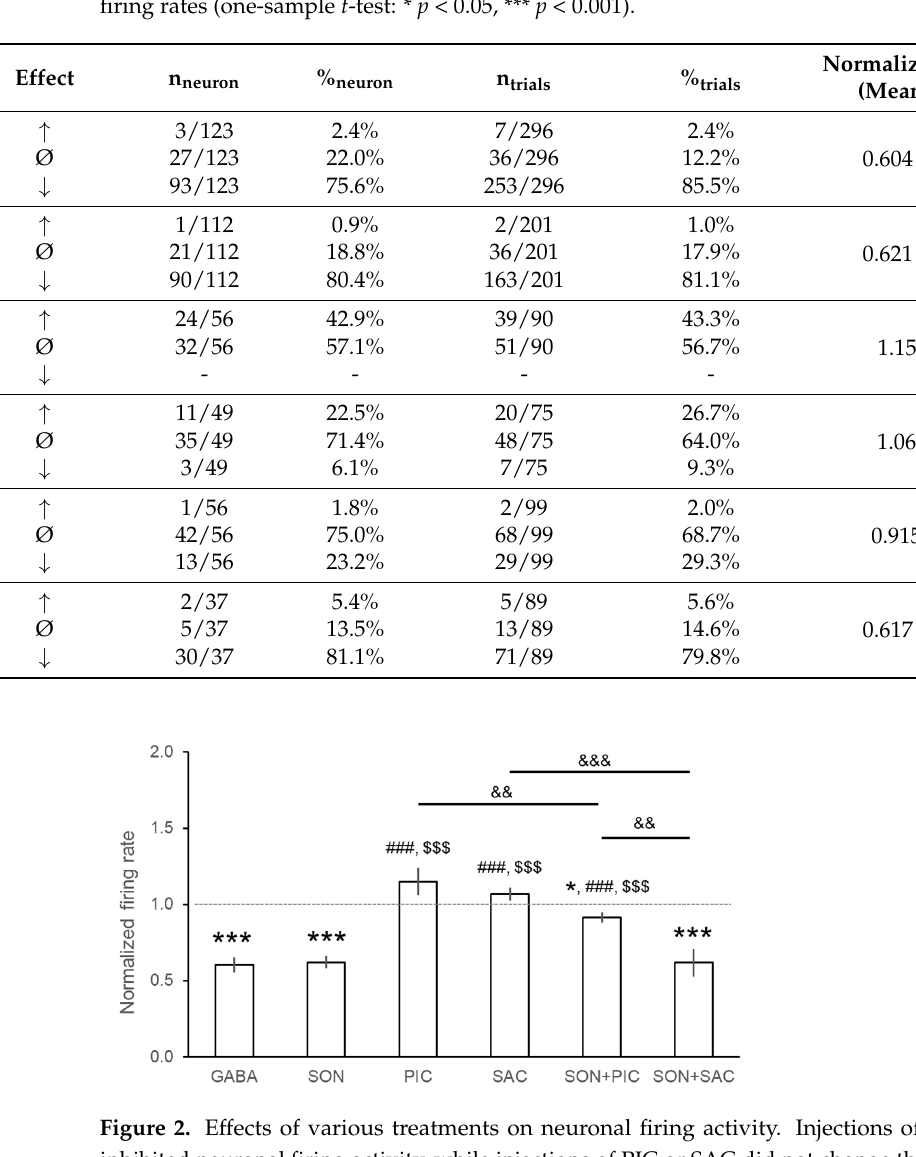
Table 1. Summary of neuronal firing rate changes (increase: ↑ , decrease: ↓ , or no change: Ø) in the rat brain elicited by local administration of various pharmacological agents and their combinations.